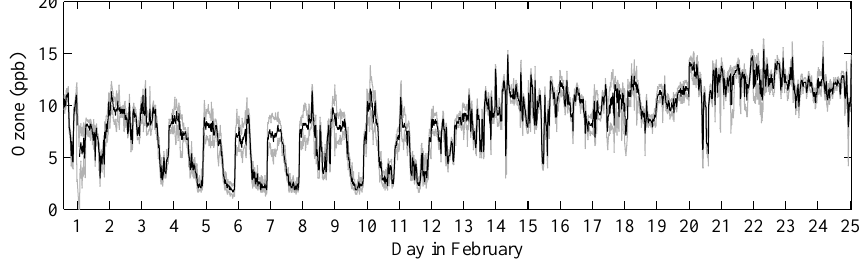
Figure 14. Time series plot of ozone concentration (in ppbv) measured on the ground by the TECO-49 ozone monitor. The black line is the 15min median ozone concentration, and the grey lines are the 10th and 90th percentiles. A strong diurnal cycle is established between 3 and 12 February, which disappears on 13 February, replaced by a higher, more constant ozone concentration of ∼